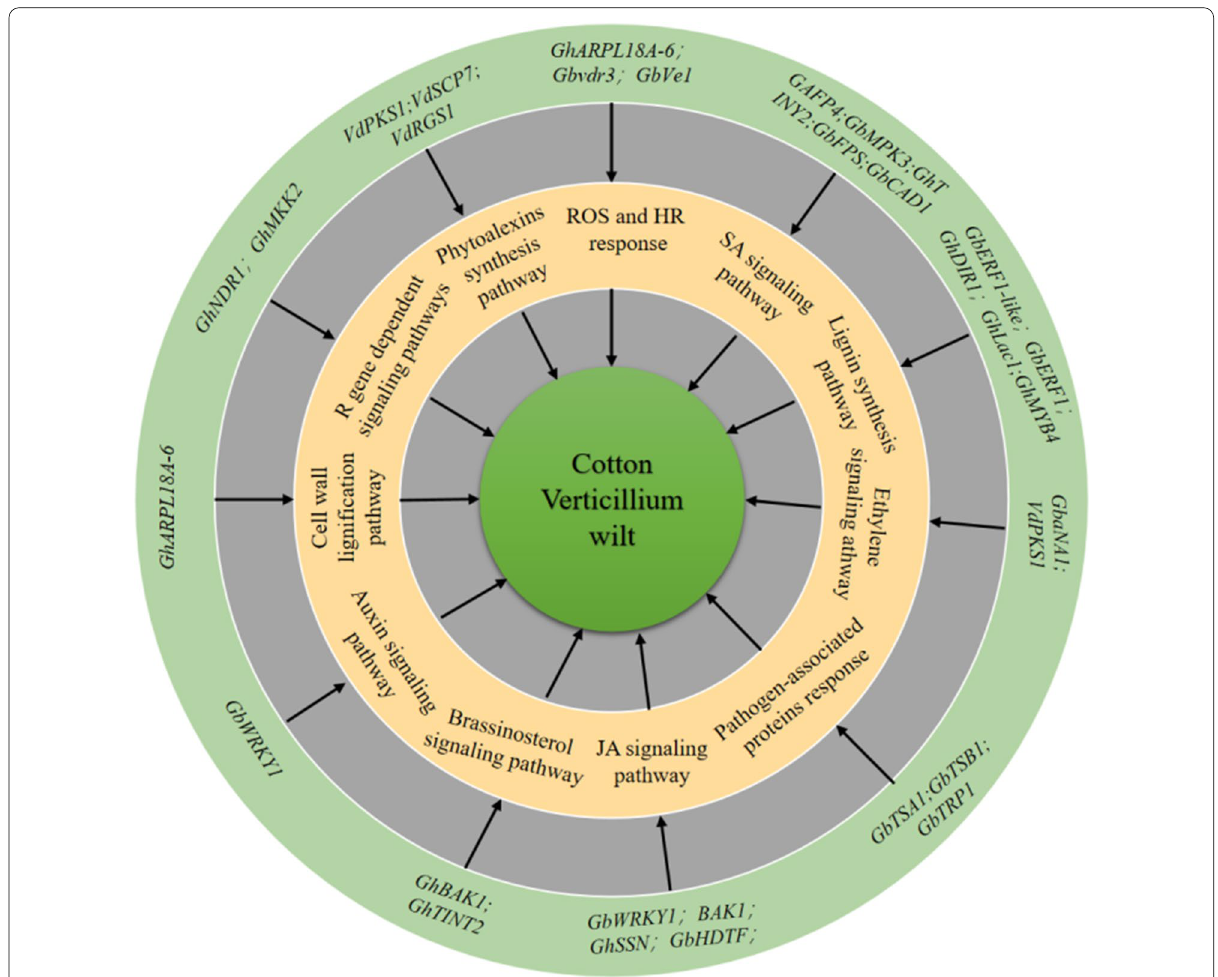
Fig. 2 Functional genes related to cotton resistance to Verticillium